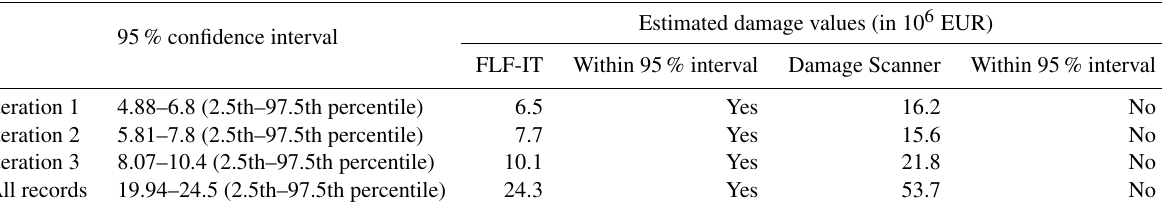
Table 3. Comparison of total absolute losses estimated by FLF-IT with the 95% confidence interval of the resampled damage records.